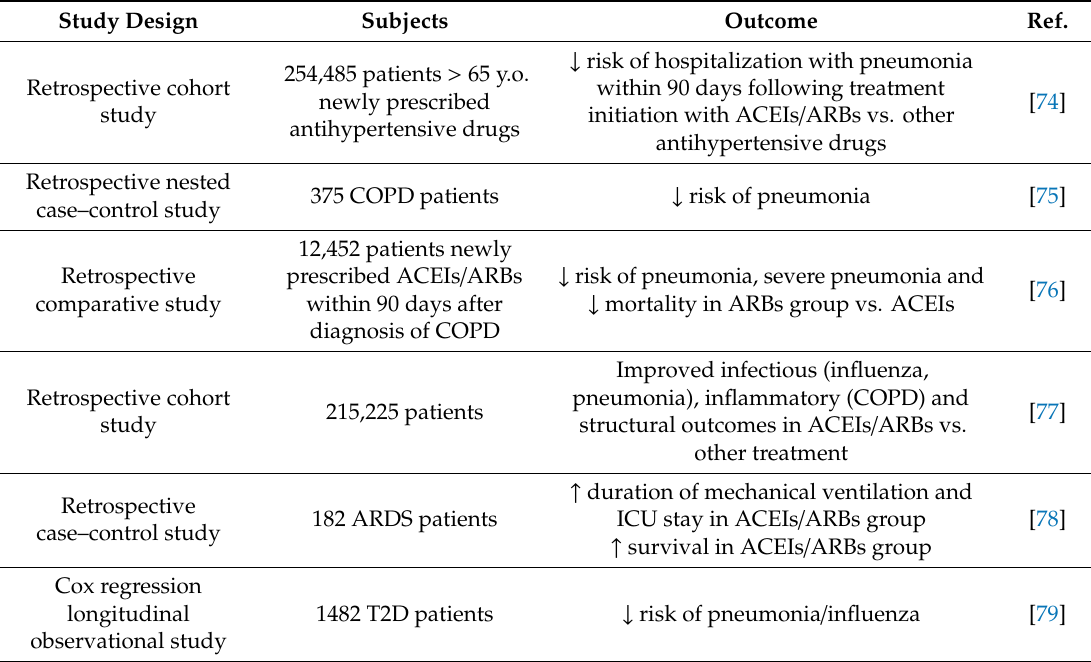
Table 1. E ff ect of pharmacological inhibition of the renin–angiotensin system on respiratory